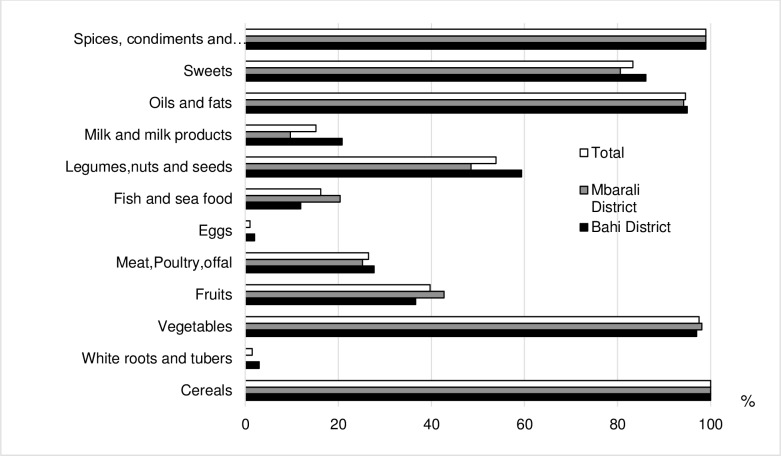
Percentage of households who consumed each food group in 2015.